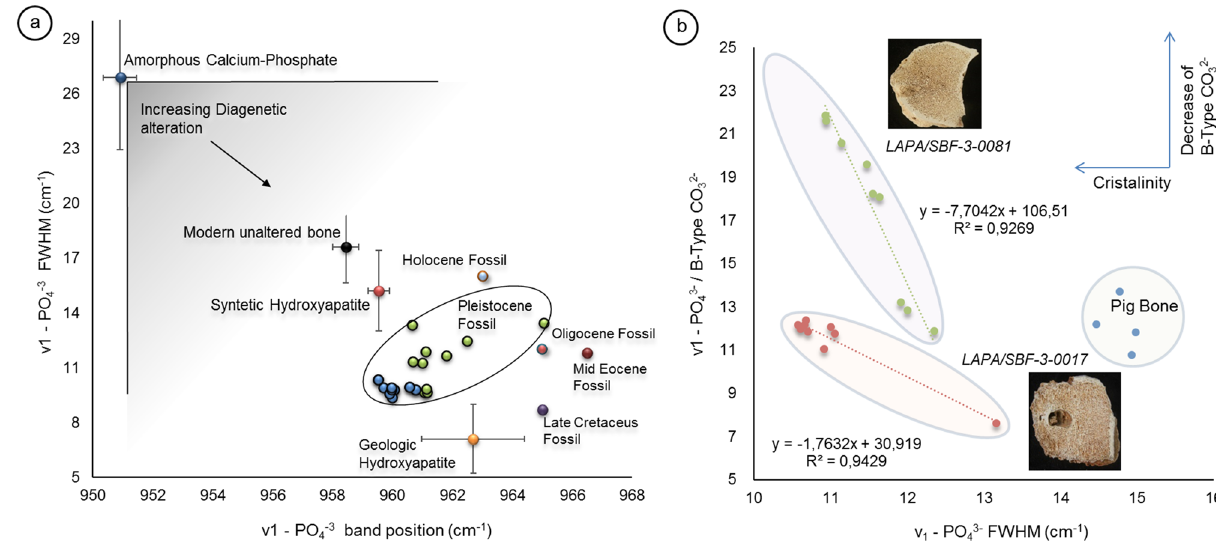
Figure 9. Characteristics of the Raman spectra of the LAPA/SBF-3-0017 and LAPA/SBF-3-0081 samples. ( a )— Band position of v1-PO 4 3− about its peak width at half-height of the data obtained in this research (Pleistocene fossils, points green and blue in image ‘ a ’) compared with available data in the literature (Supplementary Table S4). ( B )—Relationship between crystallinity (FWHM of v1-PO 4 3− ) and the existence of B-type carbonate within the bone structure (v1-PO 4 3− /B-type CO 3 2−